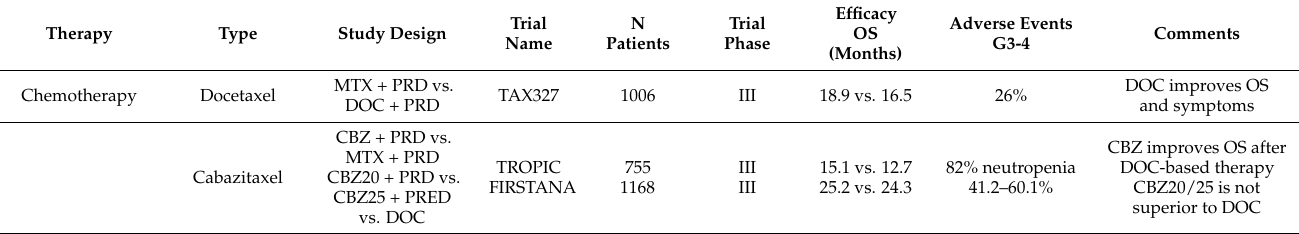
Table 1. Current treatments in